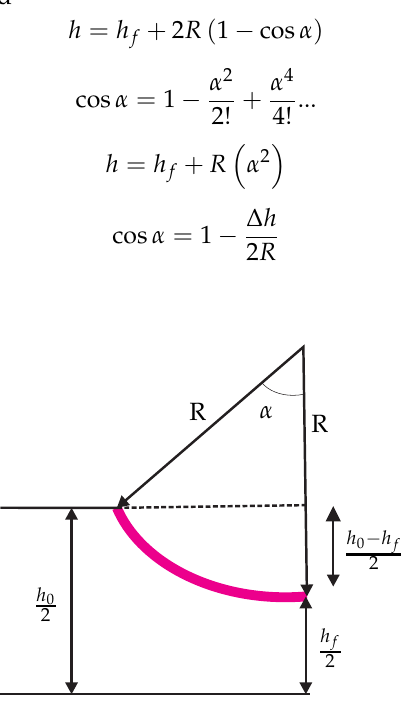
Figure 6. Analysis of angle contact bite with a given radius of rolling die